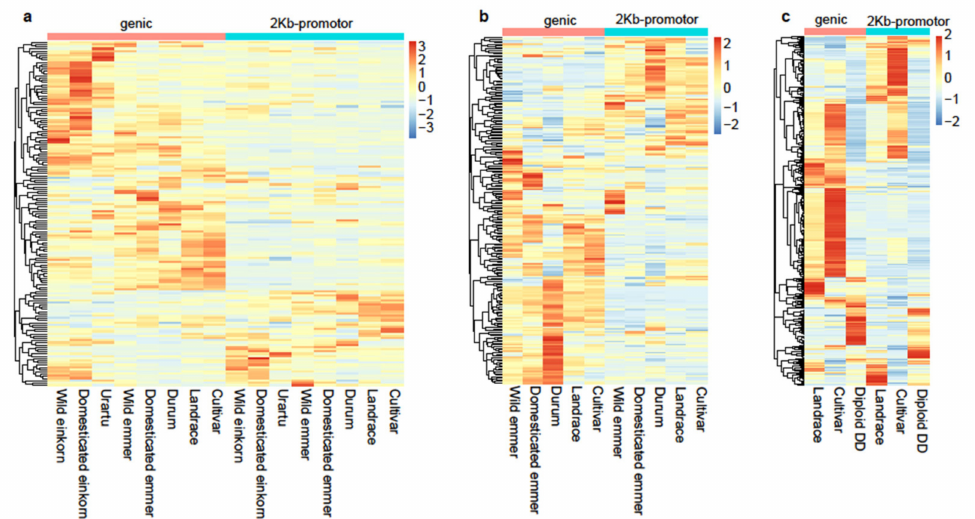
Figure 4. The heatmap of ORS (occurrence rate of SNP) on genic regions and 2 Kb-promoter regions of all NLRs with SNPs for nine groups in different subgenomes. ( a ) The heatmap for A genome lineages in wild einkorn, domesticated einkorn, urartu, wild emmer, domesticated emmer, durum, landrace, and cultivar groups; ( b ) the heatmap for B genome lineages in wild emmer, domesticated emmer, durum, landrace, and cultivar groups; ( c ) the heatmap for D genome lineages in landrace, cultivar, and diploid DD groups. Red cells represent the higher ORS, and blue cells represent the lower